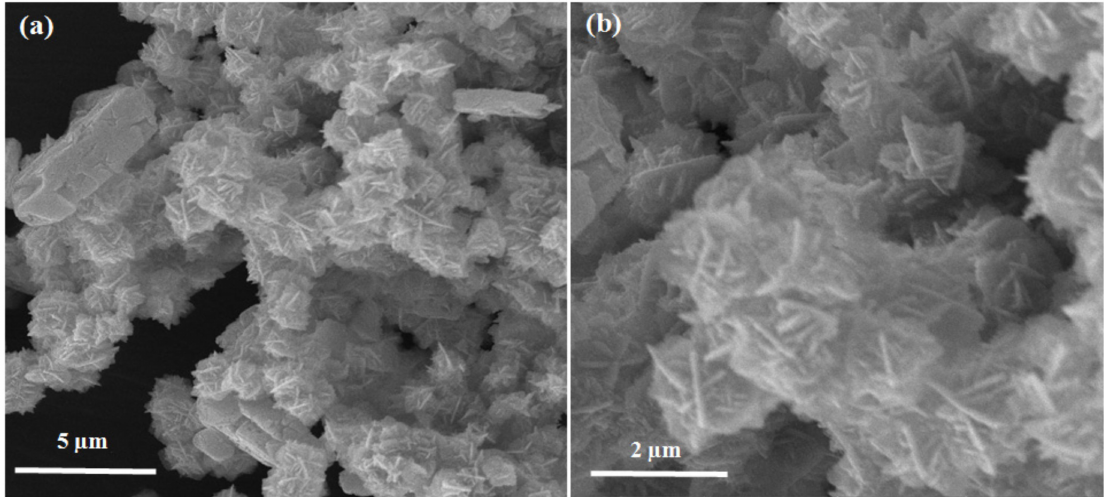
Figure 2. Scanning electron microscopy of zinc oxide nanoparticles at ( a ) 10,000 × , ( b ) 25,000 × magnifications.